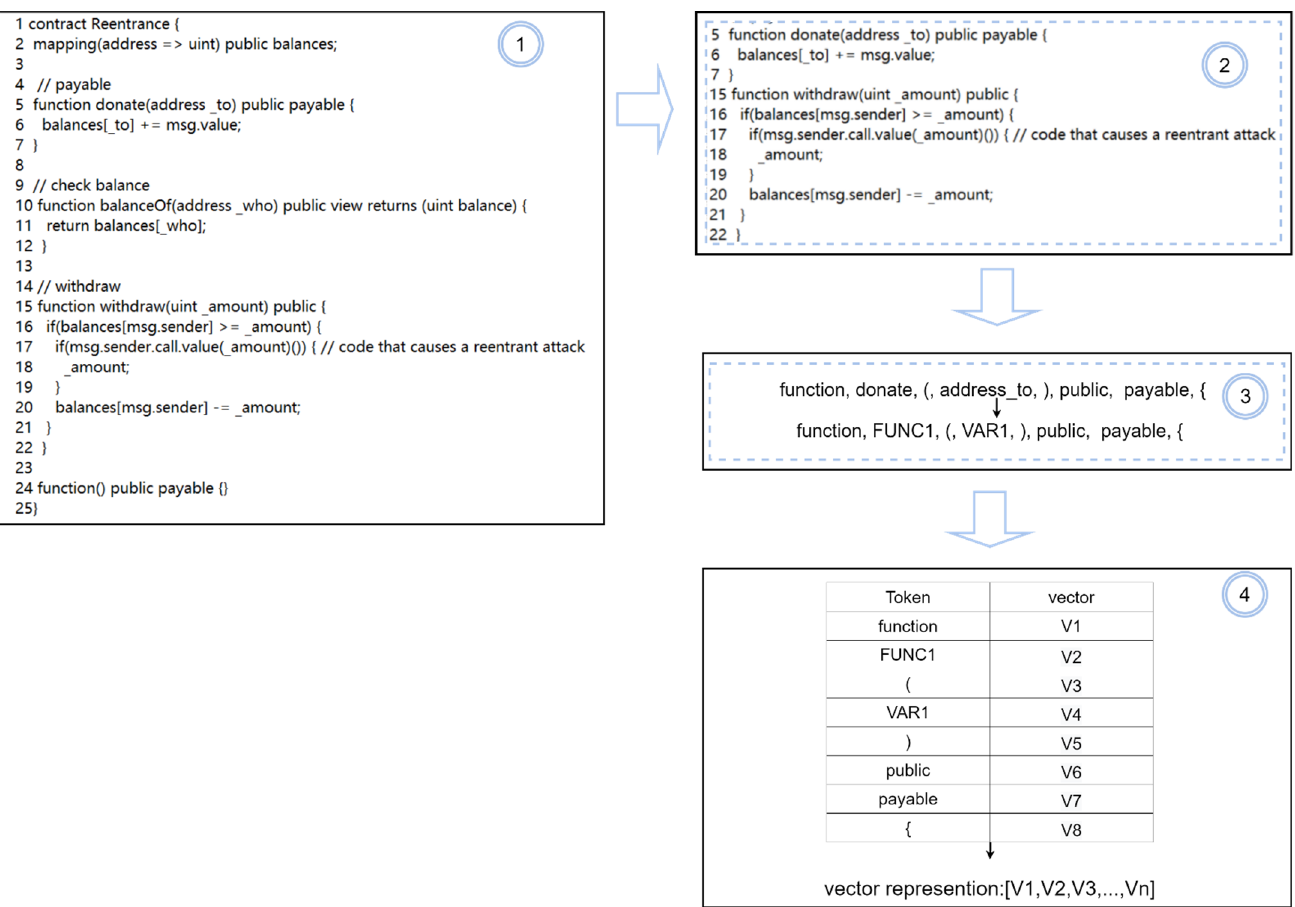
Figure 4. The code embedding process. ① – ④ represent the process of representing the original smart contract code into vectors.